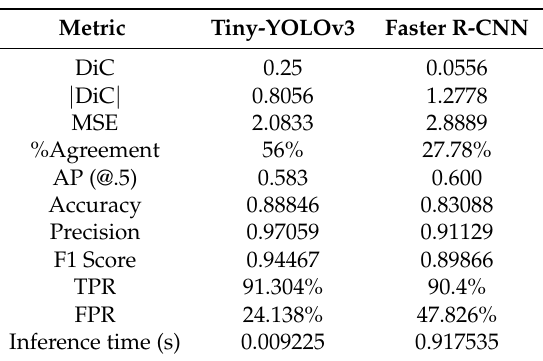
Table 1. Network evaluation